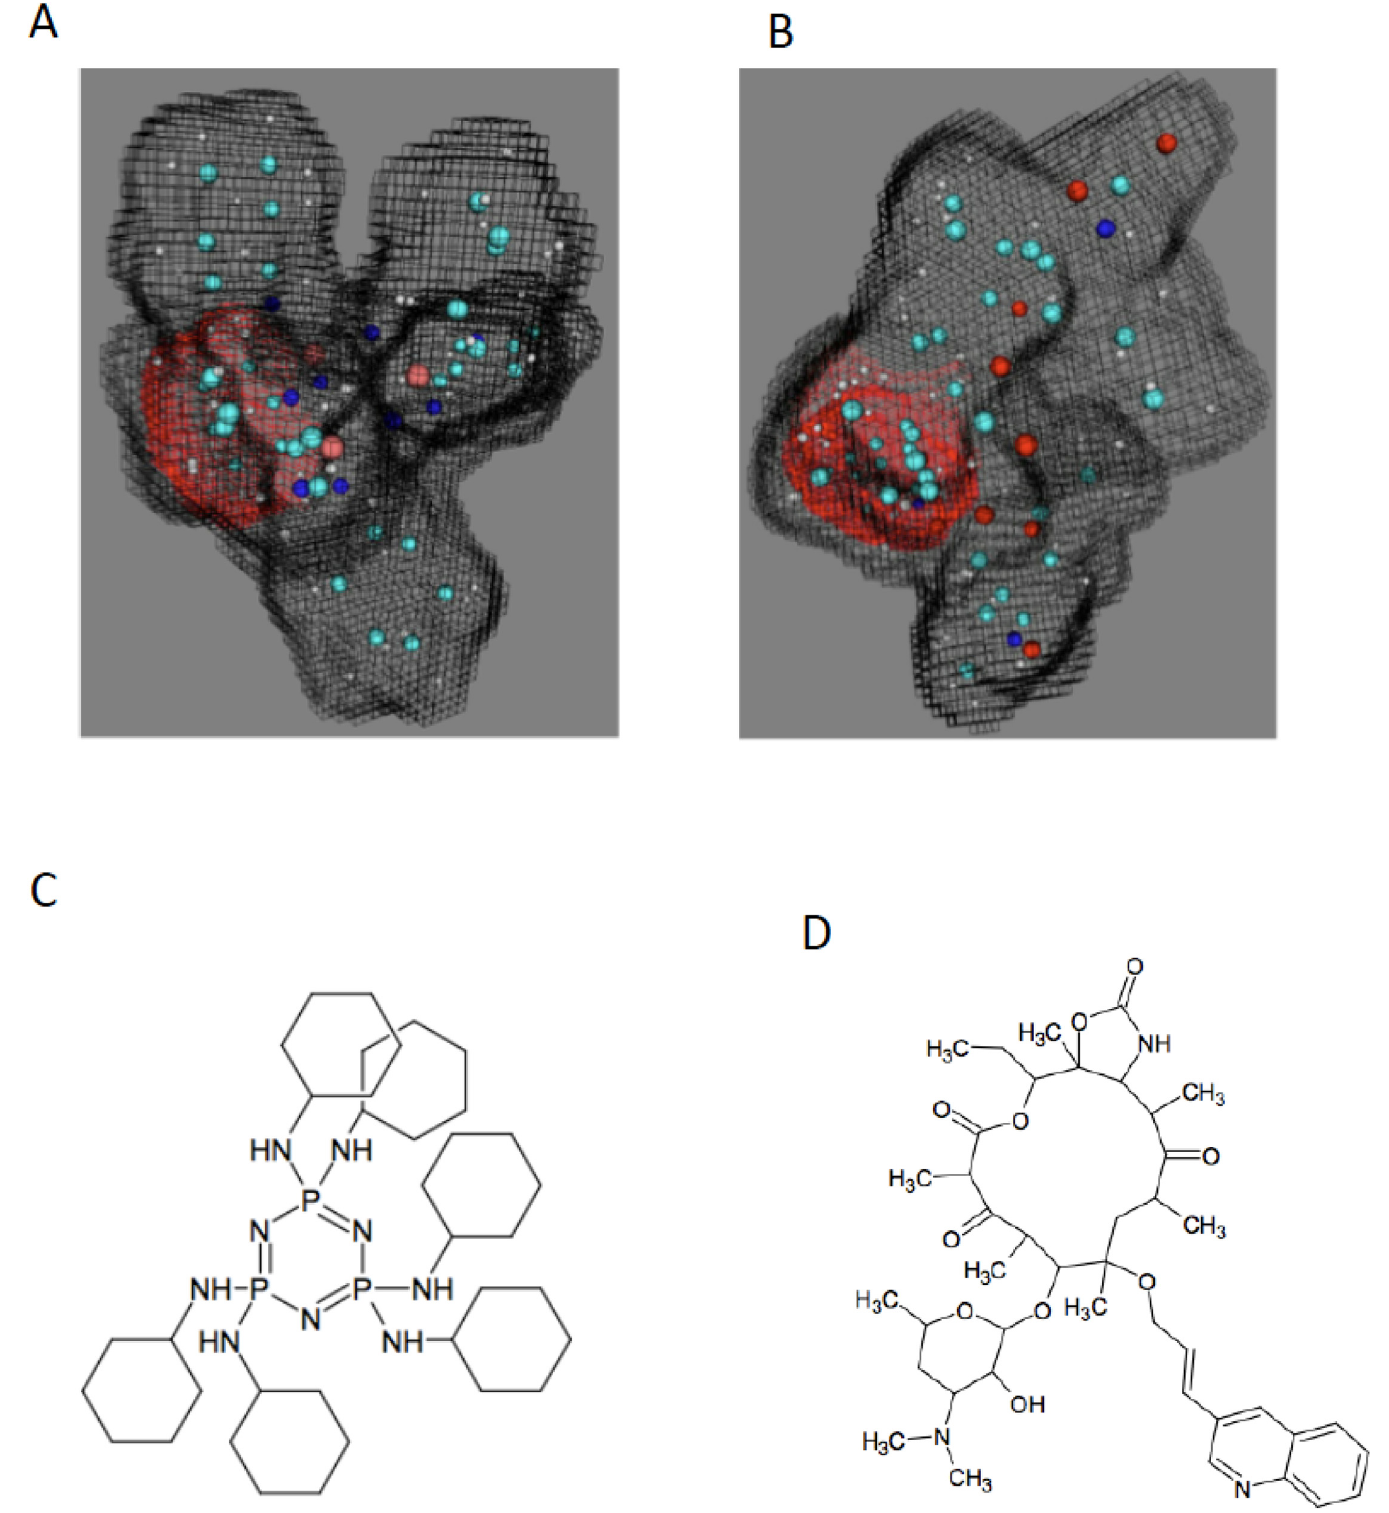
Fig 1. Liver-stage Quantum Components. Quantum similarity of A. GNF-Pf-1498 and the quinoline-macrolide hybrid B. cethromycin that is related to CHEMBL440116 as well as chemical structures of C. GNF-Pf-1498 and D. cethromycin.